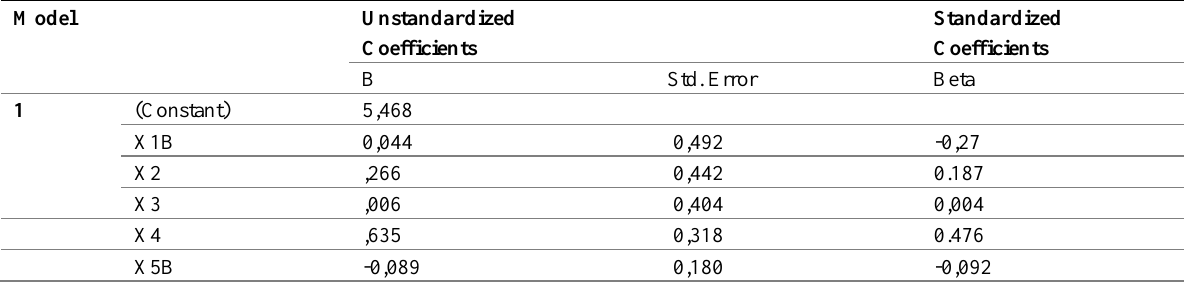
Table 5: Multiple Linear Regression Test Results